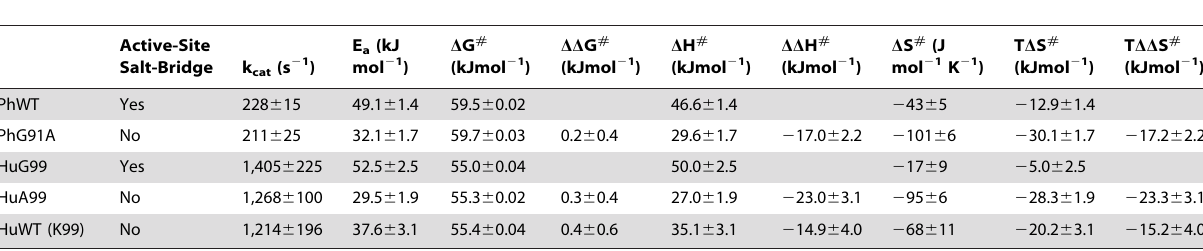
Table 1. Kinetics parameters of acylphosphatases with and without the active-site salt-bridge.